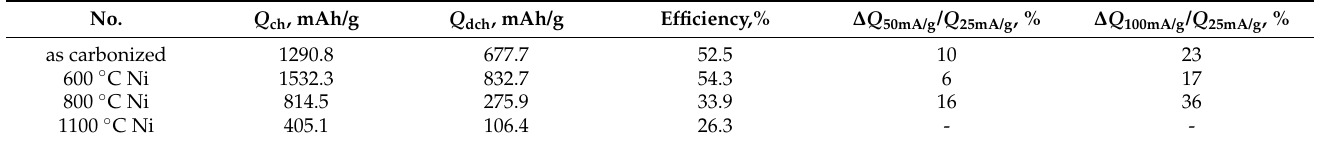
Table 1. Values of capacity, Coulombic efficiency of the first cycle and drop of capacity with increasing current density ( j ) after 10 cycles.